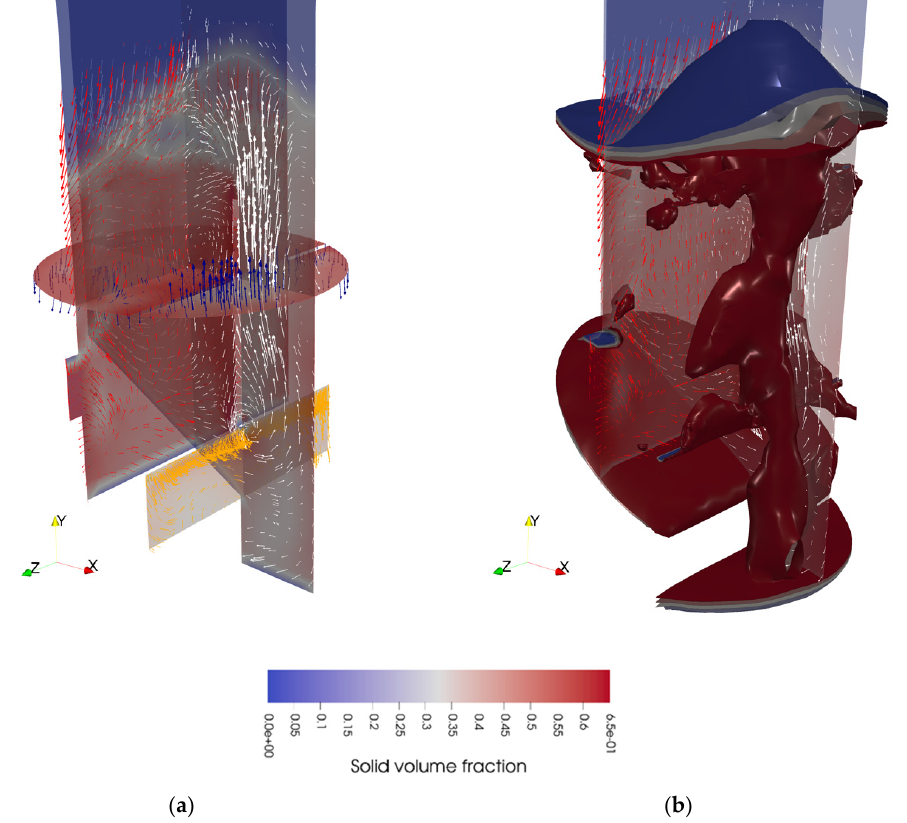
Figure 12. 3D-CFD visual representation at simulation time t = 10 s: ( a ) solid phase volume fraction and solid velocity field visualization on main section planes (colors of arrows are only delimiting the cutting plane where vector field is displayed); ( b ) granular solid phase iso-surfaces (red 𝜀 (cid:3046) = 0.35 , blue 𝜀 (cid:3046) = 0.15 ) delimiting bubbles formation inside the two chambers.